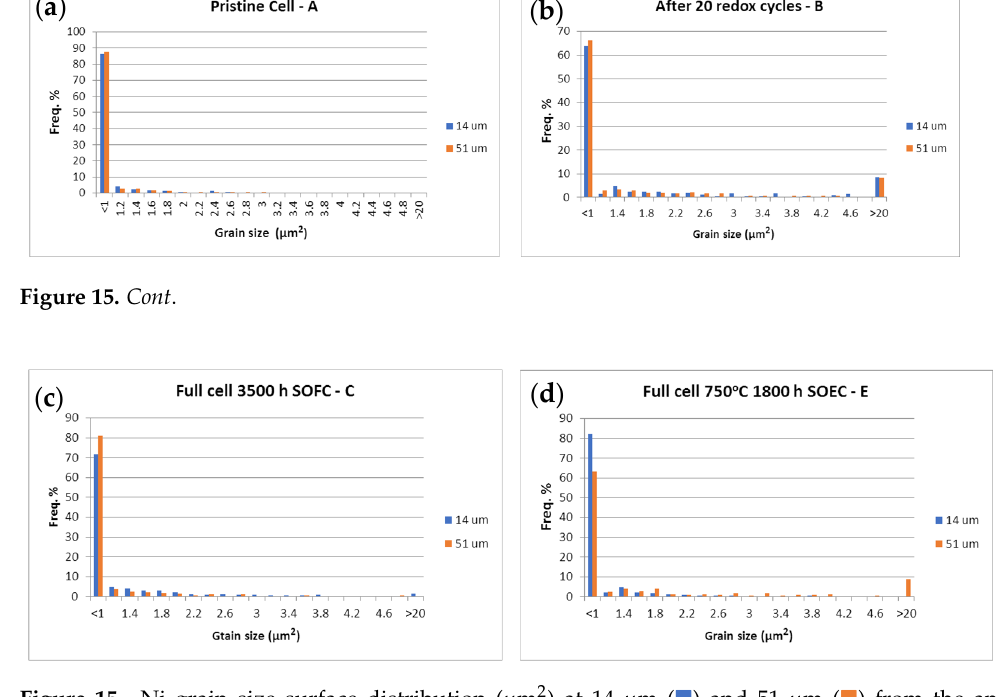
Figure 15. Ni grain size surface distribution (µm 2 ) at 14 µm ( ■ ) and 51 µm ( ■ ) from the anode/electrolyte interface.